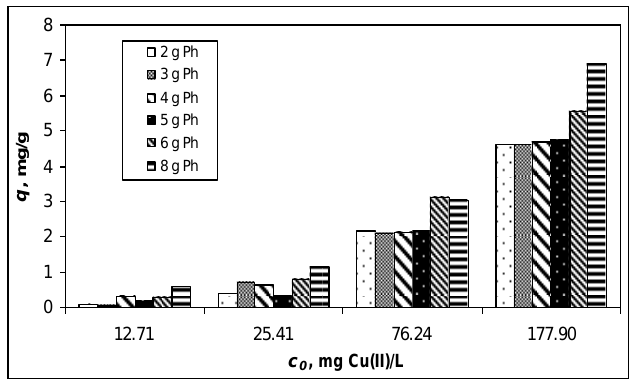
Water 2020 , 12 , x FOR PEER REVIEW 6 of 12